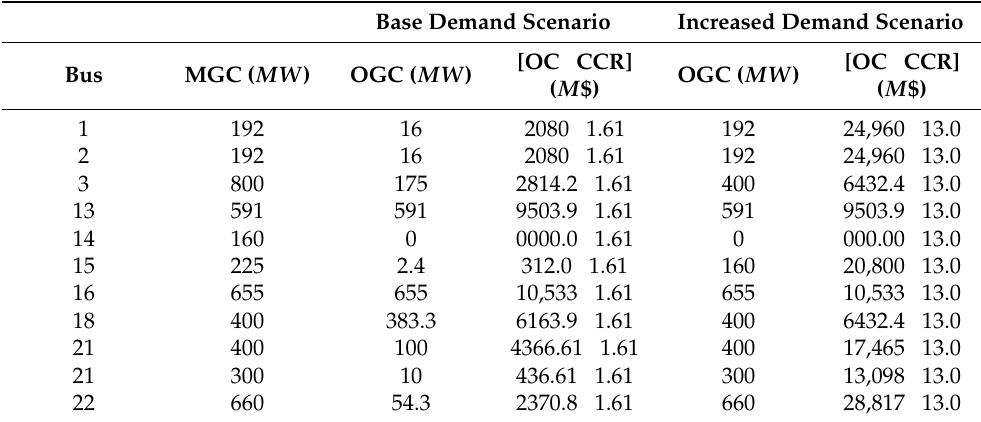
Table 9. Result of the base year optimal generation capacity versus optimal generation capacity with demand increase in a 24-bus system.